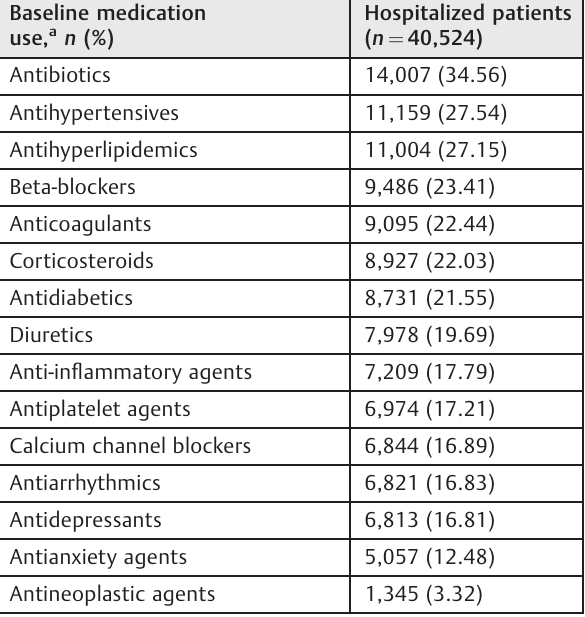
Table 2 Baseline medication use in hospitalized COVID-19